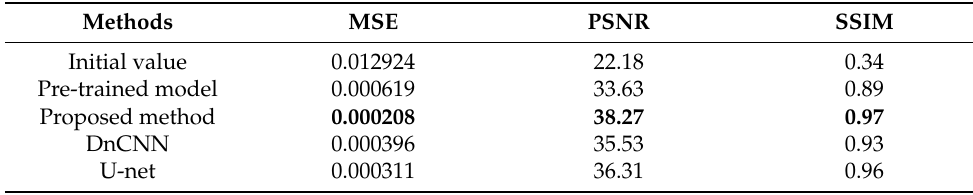
Table 7. Quantitative comparison of all test data sets.